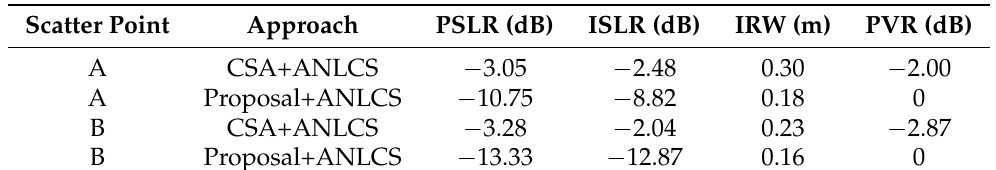
Table 4. Focus performance comparsions.